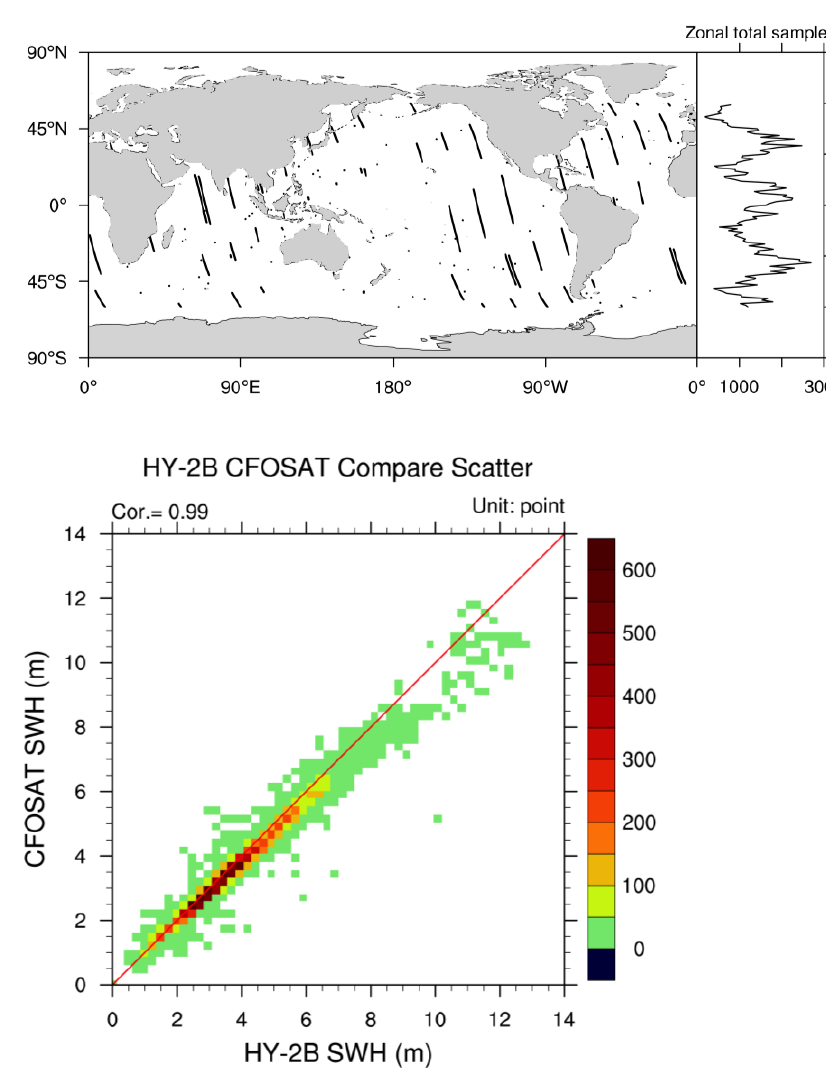
Figure 9. Locations of matched points between HY − 2B and CFOSAT nadir measurements and zonal total samples at every latitude ( top ), and a scatter − point density plot of HY − 2B versus CFOSAT SWH ( bottom ). The data were selected with a 50 km spatial window and 30 min time window between CFOSAT and HY − 2B observations between 60°S and 60°N.